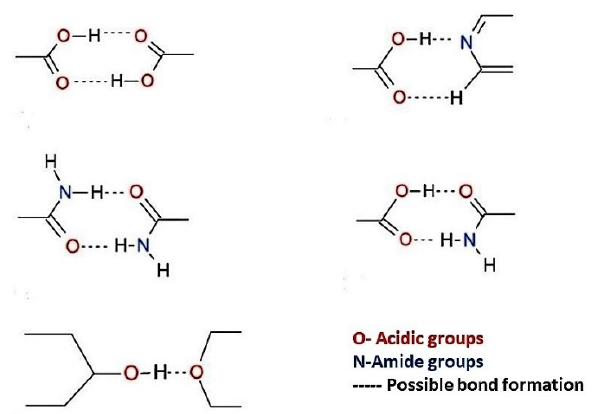
Figure 5. Common supramolecular synthons formed from carboxylic acids, amides, pyridines, and other aromatic nitrogen.